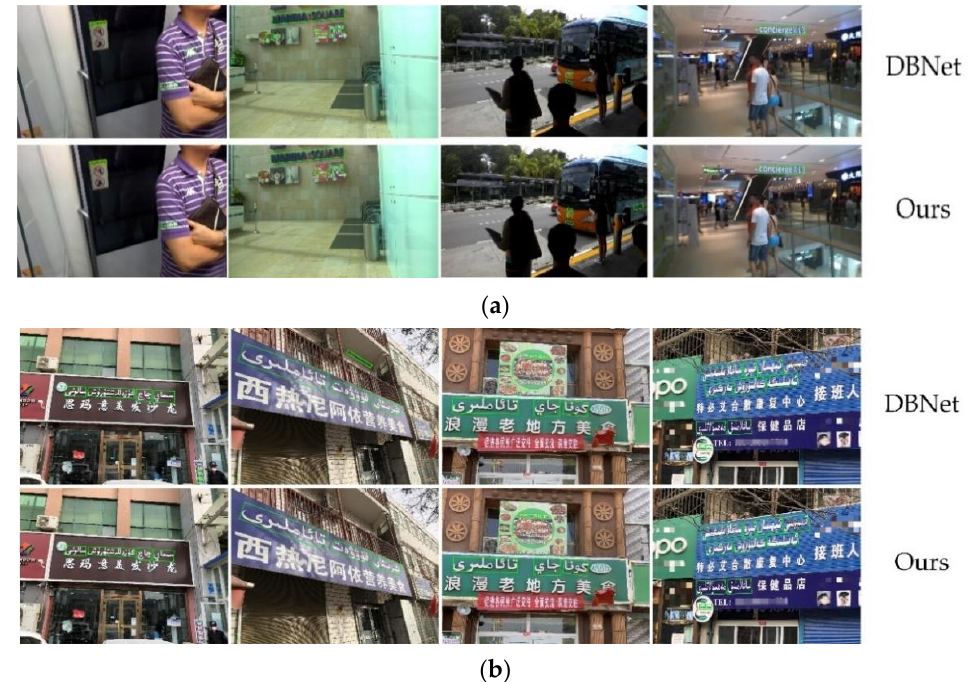
Figure 9. The visualization results of this method and baseline method on different datasets. ( a ) The text detection example on the public English dataset ICDAR2015; ( b ) the text detection example on self-built Uyghur dataset. (Text description in the figure ( b ) are Simayi hair salon; Xireniayi nutri-